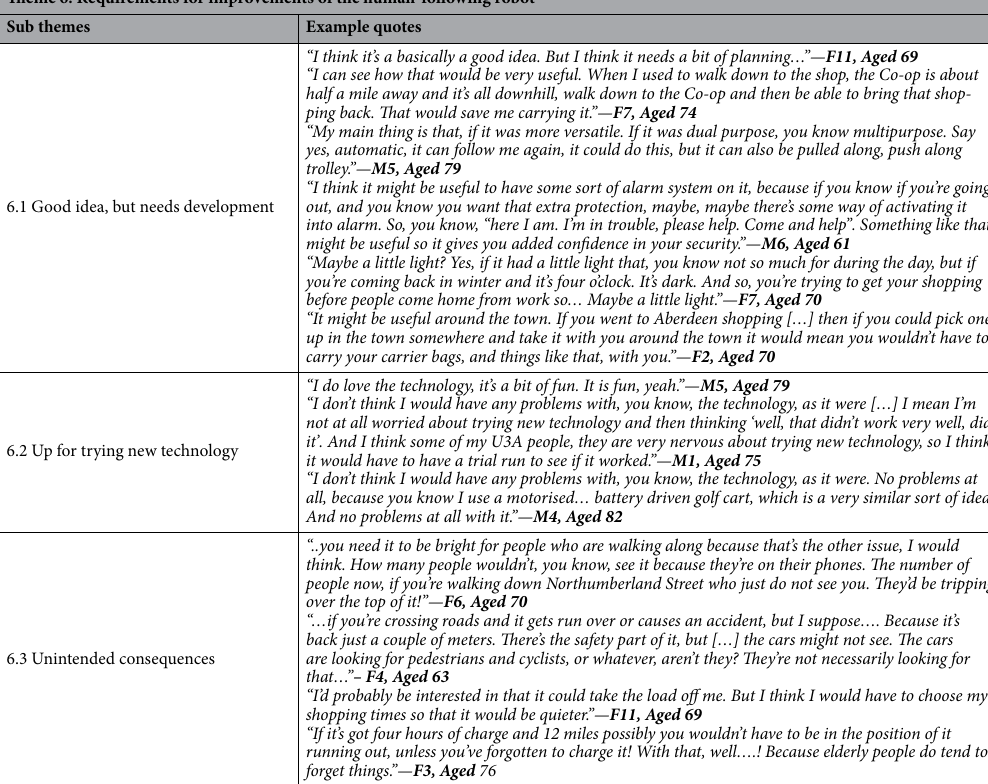
Table 7. Requirements for improvements of the human-following